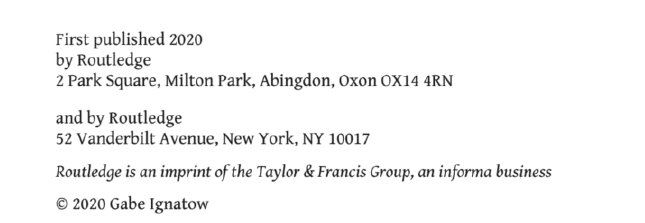
Fig. 1. Fragment of the colophon page in ‘Sociological Theory in Digital Age’ by Gabe Ignatow To complicate the matters further, we need to take into account that Routledge is